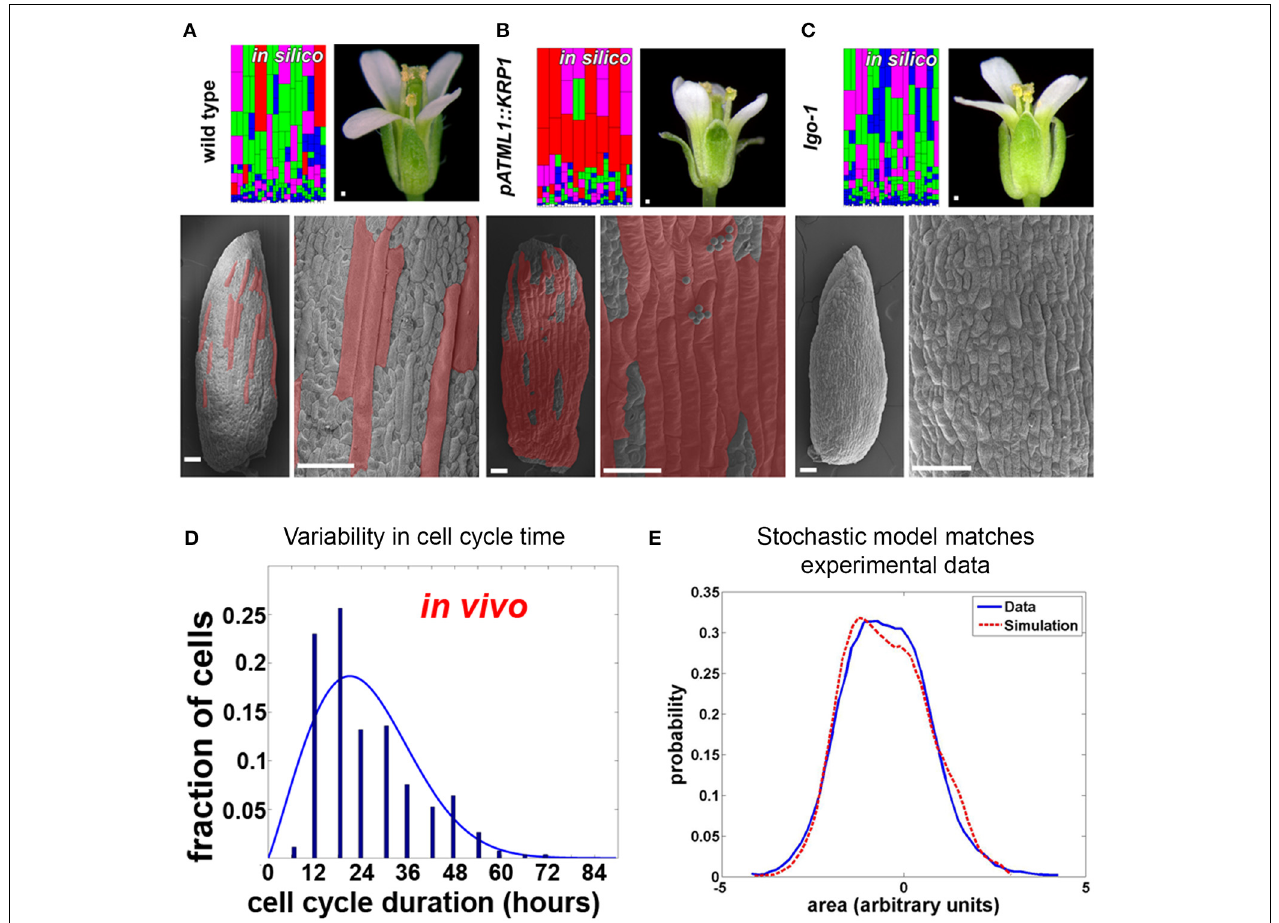
FIGURE 4 | Timing of Arabidopsis sepal epidermal cell division and entry into endoreduplication is variable. (A) Wild type sepals (the outermost, green, floral organs) have a diversity of cell sizes on the outer epidermis ranging from giant cells (false colored red in SEMs) to small cells (not colored). A stochastic computational model that accounts for cell cycle length and entry into endoreduplication can accurately predict the distribution of sepal cell sizes from wild-type plants. In the model, cells are colored according to the number of endocycles they have undergone (red = 3, purple = 2, green = 1, and blue = 0). (B,C) Changing the expression of cyclin dependent kinase inhibitors (CKI) alters the probability of entry into endoreduplication and the resulting cell size distribution. As the model